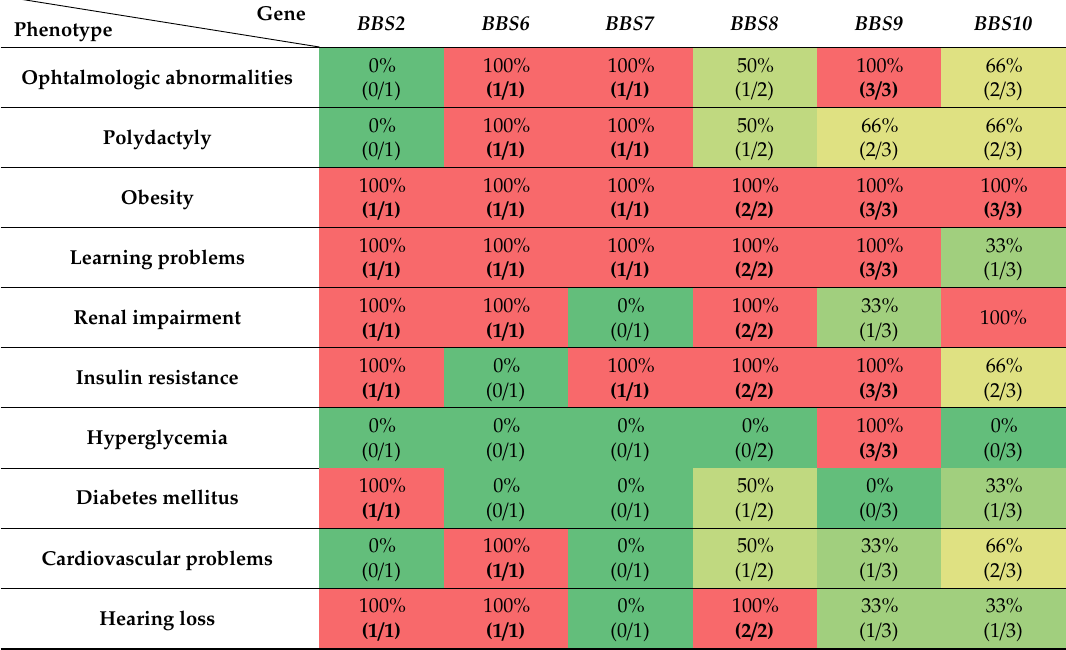
Figure 2. Chromatograms of the new variants: ( a ) NM_024685.4:c.680_681delGCinsAA in BBS10 gene (Patient BBS No.1). The arrow indicates the location of the nucleotide change: two GC nucleotides are deleted and two A nucleotides are inserted: GGC (Gly) to GAA (Glu). ( b ) NM_170784.2:c.595_596delAG in BBS6 gene (Patient BBS No.8 and BBS No.9). The arrow indicates the location of the nucleotide change: deletion of AG. Table 3. The association (the heat map) between selected clinical features in patients and variants found in BBS